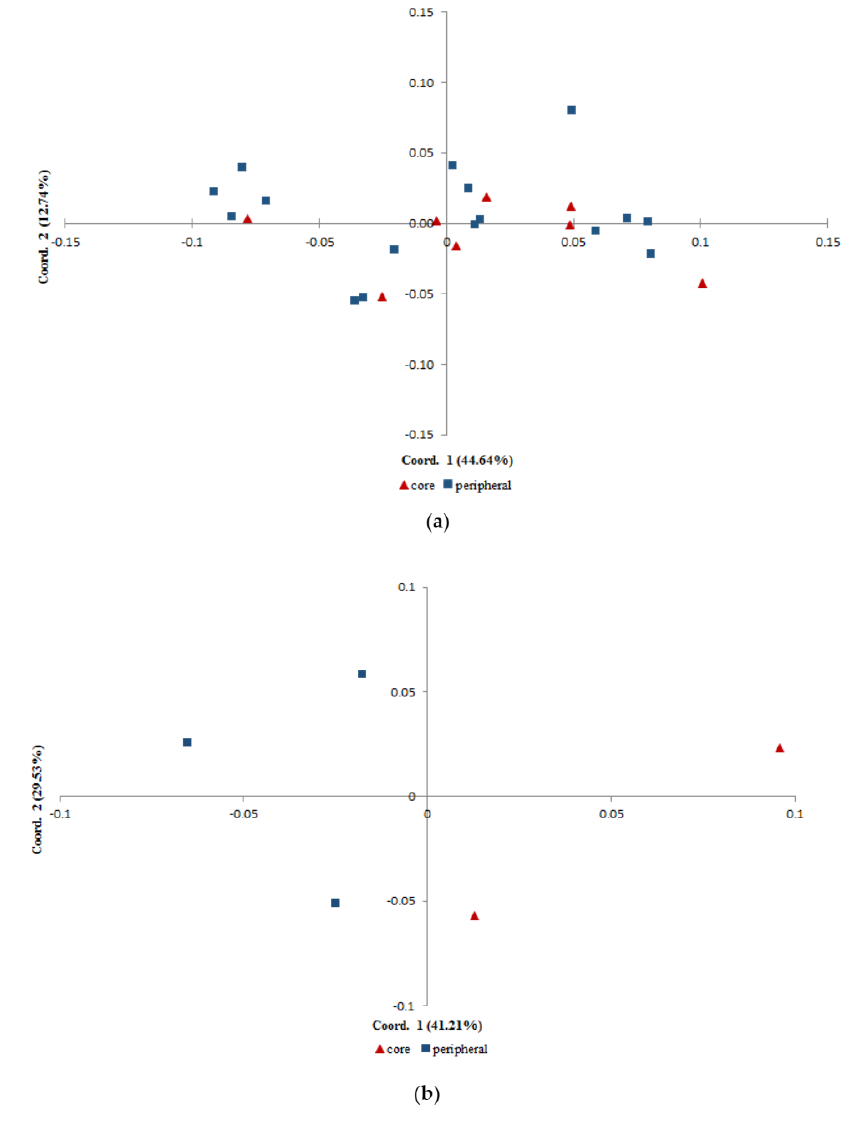
Figure 2. Results of Principal Coordinate Analysis ( PCoA ) of the individual trees of Pinus arizonica ( a ) and P. cembroides ( b